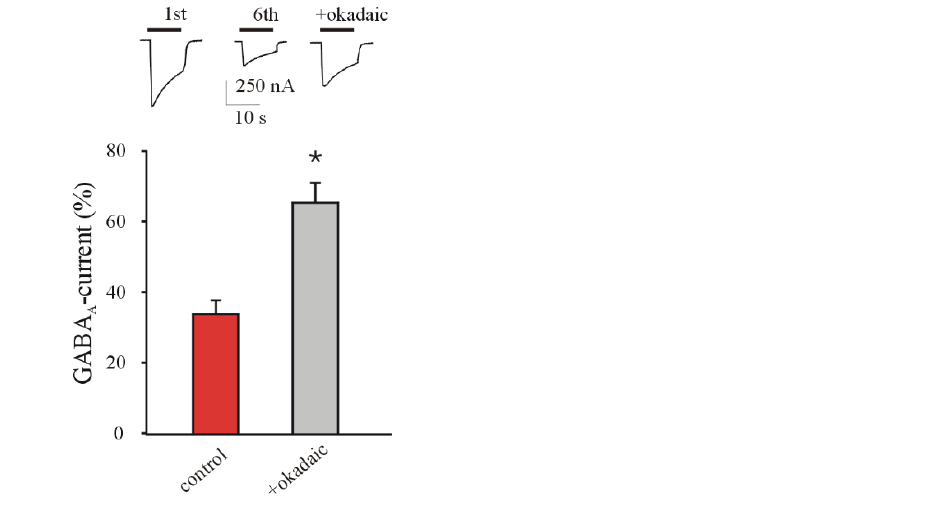
Figure 3. Effect of okadaic acid on GABA current rundown in oocytes expressing α 1 β 2 GABA A Rs. The bars represent mean ± SEM of GABA current rundown values before (red bar) and after (grey bar) the intracellular injection of okadaic acid ( ≈ 20 nM final concentration) n = 11; * p < 0.001, Wilcoxon Signed Rank Test. Inset: representative currents in one oocyte at first and sixth GABA application of rundown protocol and relative recovery after application of okadaic acid.